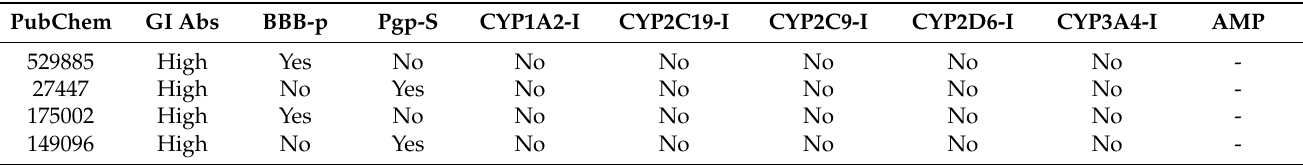
Table 3. Comparative pharmacokinetics and toxicological analyses of studied molecules. Pharma- cokinetics analyses were performed with SwissADME, and the toxicological analyses were performed with Pred-hERG and AdmetSAR